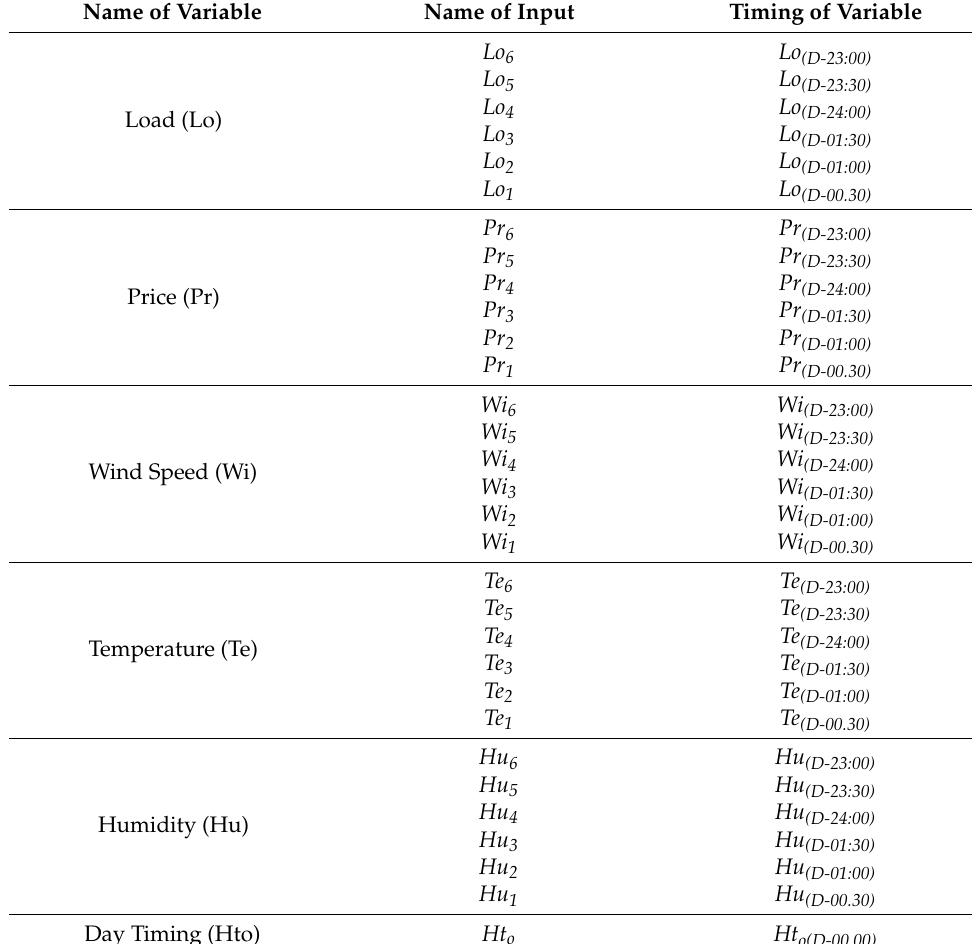
Table 1. List of input variables which affect electricity price